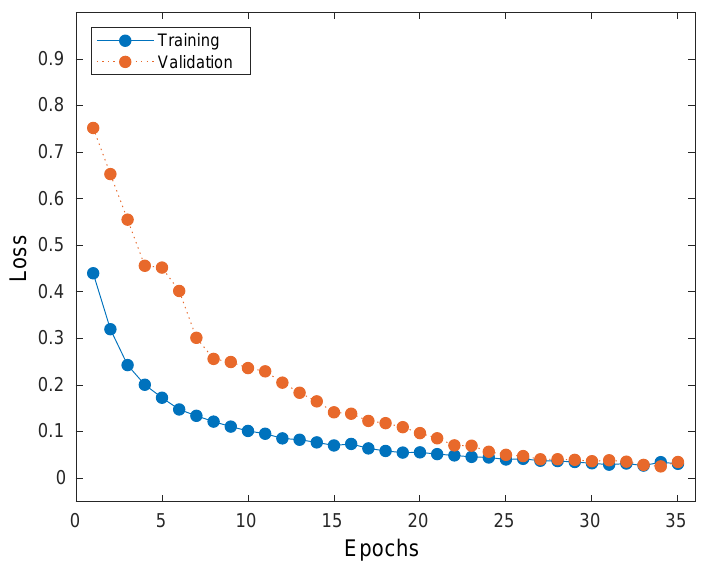
Figure 5. Comparison of loss.